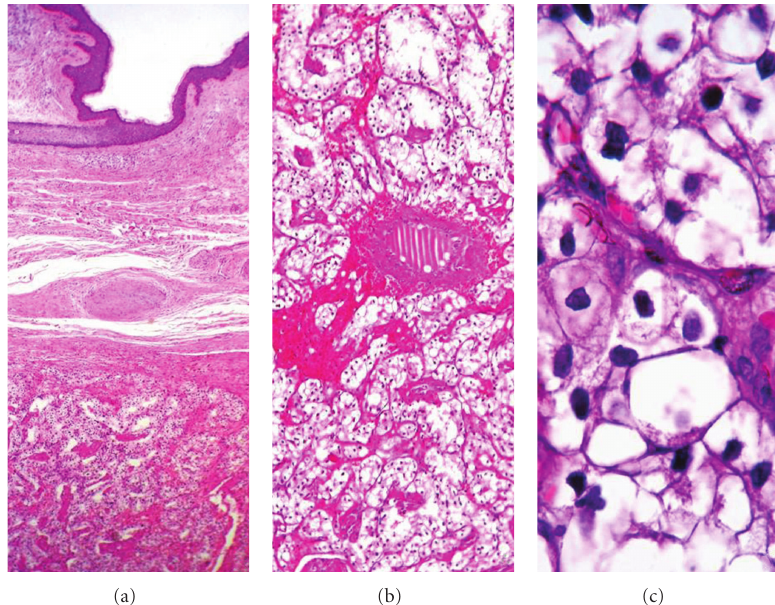
Figure 2: Histological microphotograph showing neoplastic cells with prominent nucleoli and moderate plemorphism beneath the